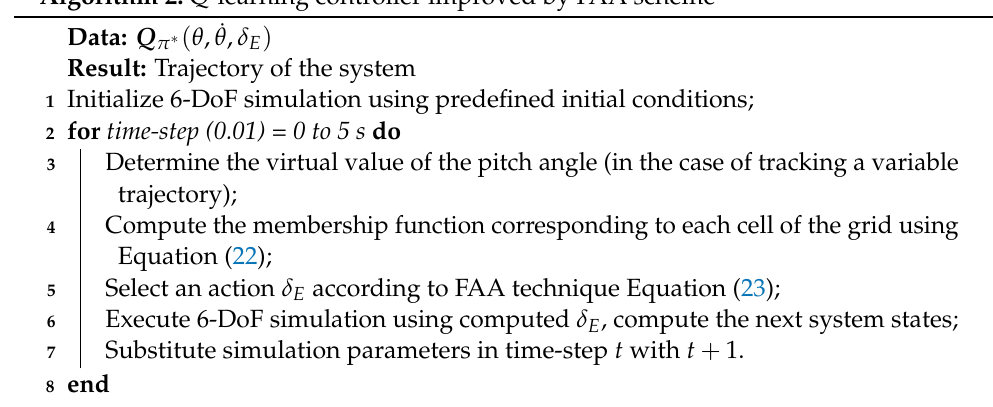
Figure 3. Grid of state variables used for tabular Q-learning (The center of each cell, which is used to compute the membership function of the cell is shown by a circle point.) Algorithm 2: Q-learning controller improved by FAA